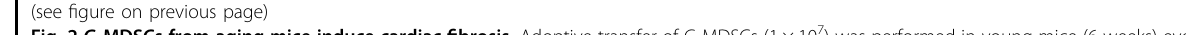
neutralizing S100A8/A9 reduced the level of intracellular ROS (Fig. 3H). Interestingly, immuno fl uorescence revealed that neutralizing S100A8 and S100A9 decreased the OPN level in fi broblasts but had no obvious effect on